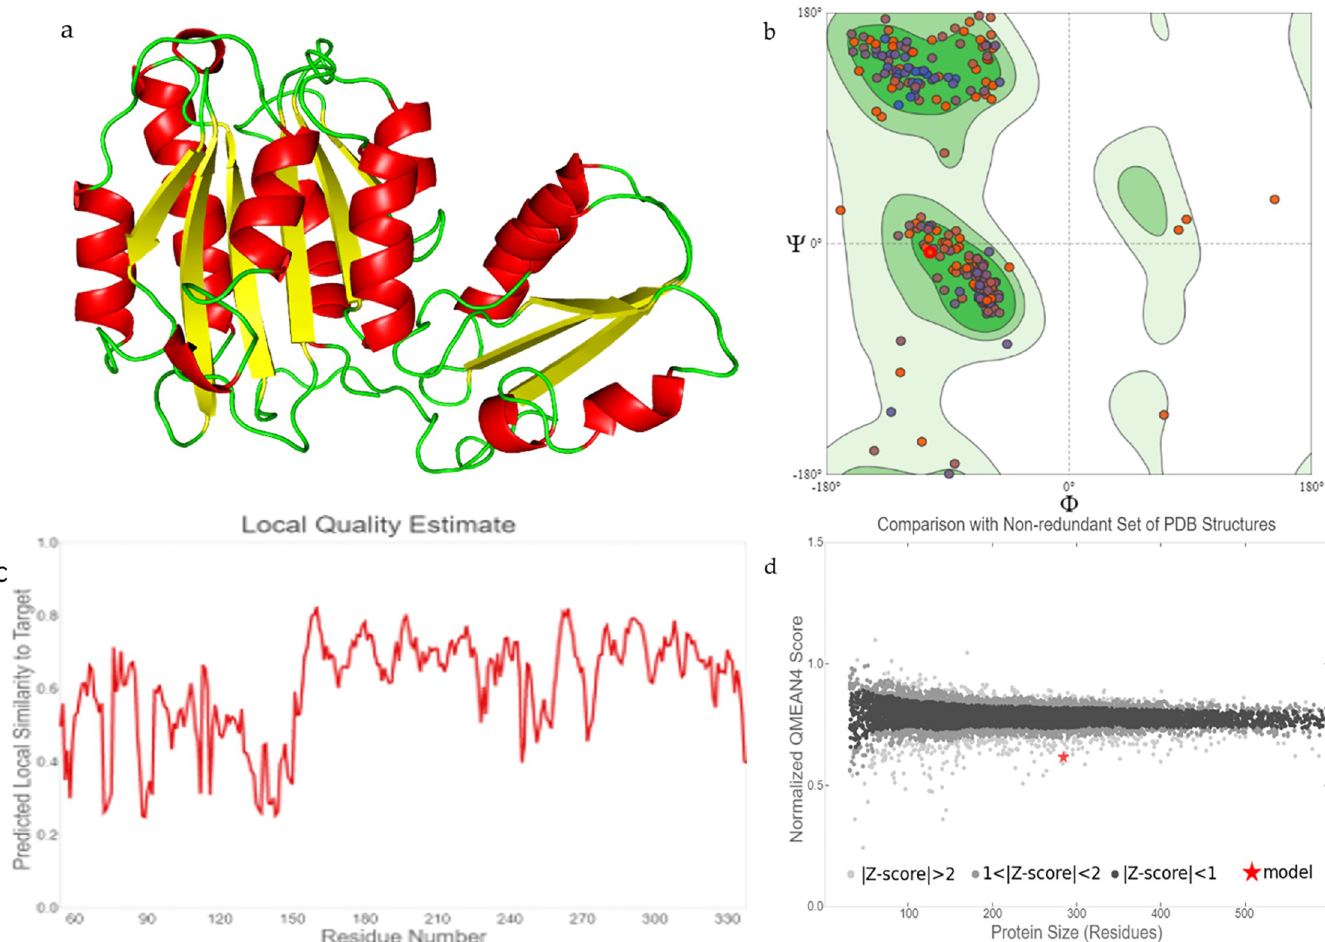
Fig 5. Homology modelled structure of snail mucus protein [Cornu aspersum] with accession number QEG59313.1. The Ramachandran modelled favoured about 92.58% residue and with a few outliers. The local quality score was on average above 0.7 for most of the residue. Finally, when in comparison with other non-redundant PDB structure, the model structure gave a ZMEAN of above 0.5 and a deviation of between 1 and 2.